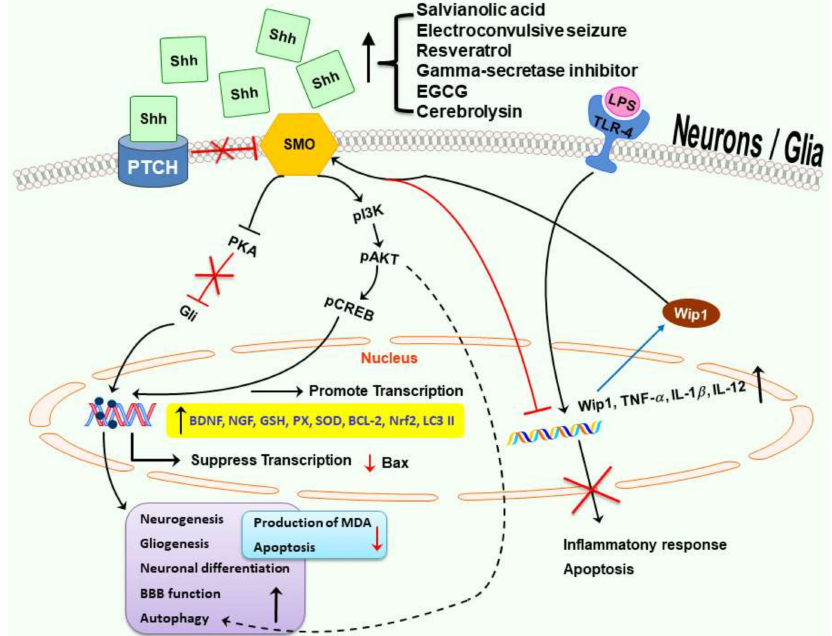
Figure 2. Multiple potential neuroprotective mechanisms in Shh signaling pathway. In the presence of Shh, inactivated Ptch relieves its suppression on Smo to activate several downstream pathways. The neuroprotective mechanisms of Shh may involve enhancement of neurogenesis, gliogenesis, autophagy, mitochondrial function, BBB function, anti-oxidation, anti-inflammation, and anti-apoptosis. Black solid or dashed arrows indicate promotion or increasing; red lines with an “T” and/or “X” indicate inhibition, suppression, or decreasing; blue arrows indicate